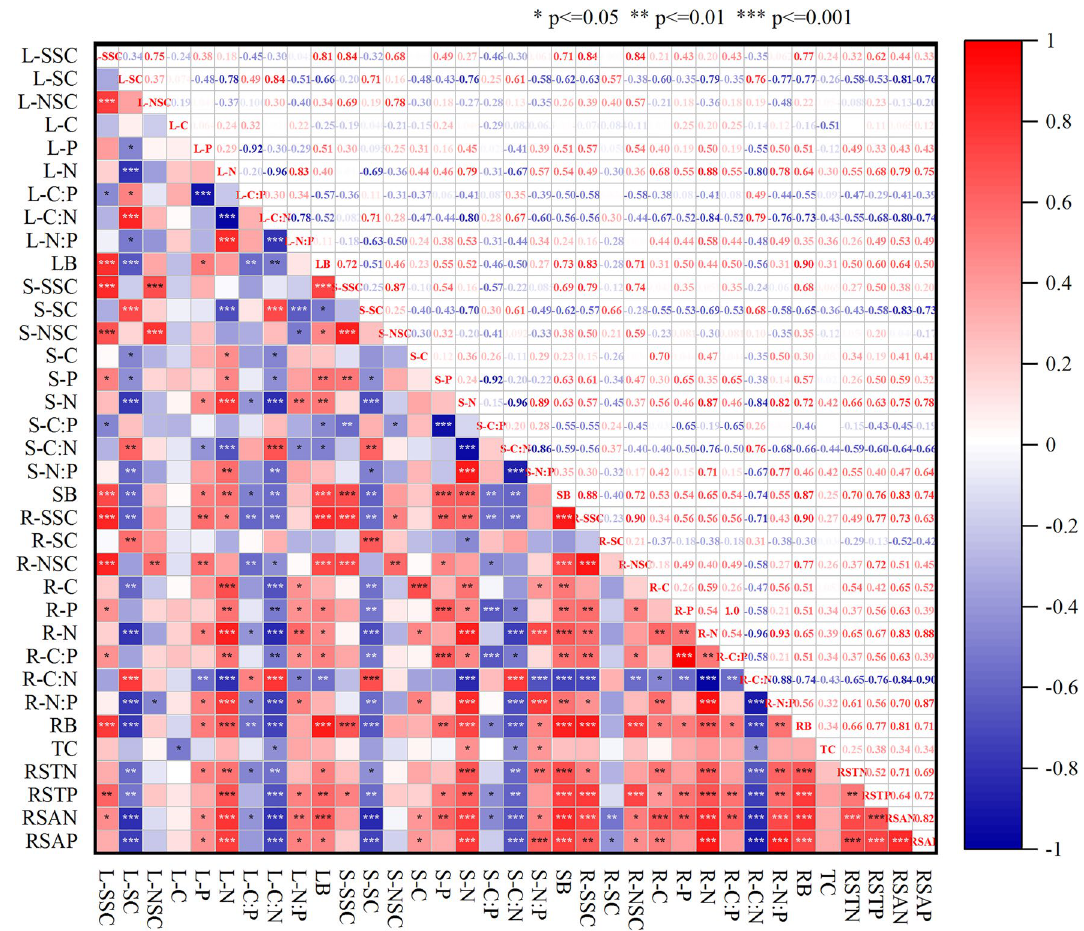
Figure 5. Correlation analysis between soil factors and ecological stoichiometry and NSCs of R. soongorica . RSAP = rhizosphere soil available P, TC = rhizosphere soil total carbon, RSTP = rhizosphere soil total phosphorus, RSTN = rhizosphere soil total nitrogen, RSAN = rhizosphere soil available N, L-SSC = leaf soluble sugar concentration, L-SC = leaf starch concentration, L-NSC = leaf non-structural carbohydrates, L-C = leaf total C, L-N = leaf total N, L-P = leaf total P, L-C:N = leaf C:N ratio, L-C:P = leaf C:P ratio, L-N:P = leaf N:P ratio, LB = leaf biomass, S-SSC = stem soluble sugar concentration, S-SC = stem starch concentration, S-NSC = stem non-structural carbohydrates, S-C = stem total C, S-N = stem total N, S-P = stem total P, S-C:N = stem C:N ratio, S-C:P = stem C:P ratio, S-N:P = stem N:P ratio, SB = stem biomass, R-SSC = root soluble sugar concentration, R-SC = root starch concentration, R-NSC = root non-structural carbohydrates, R-C = root total C, R-N = root total N, R-P = root total P, R-C:N = root C:N ratio, R-C:P = root C:P ratio, R-N:P = root N:P ratio, RB = root